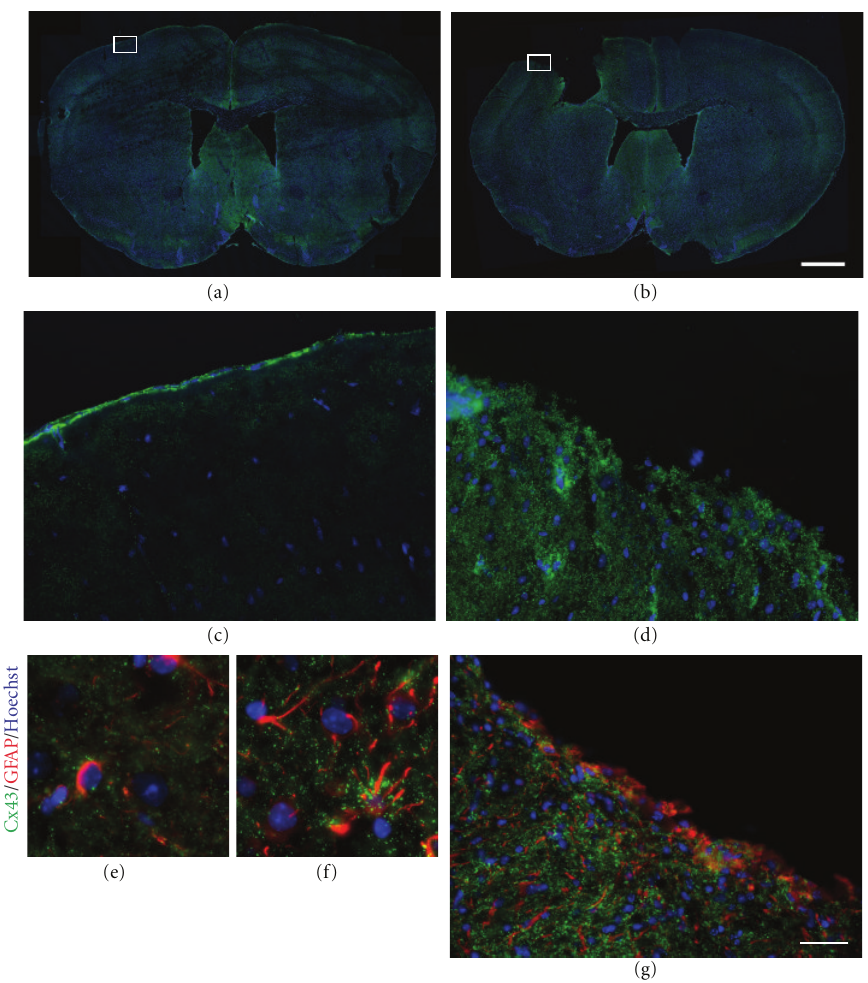
Figure 8: Cx43 expression in the control and injured motor cortices. Immunohistochemistry of Cx43 (green) in the brains of mice subjected to sham surgery (a,c,e) and motor cortex lesion (b, d, f, g). (a)-(b) The stitched confocal images show the expression of Cx43 in the control (a) and injured (b) brains. (c)-(d). Higher magnification images of the areas of motor cortex indicated by insets in (a) and (b) are shown in (c) (sham) and d (lesion). Increased Cx43 staining was observed in the cortex adjacent to the injury site compared to sham cortex. (e)–(g). Double-labeling with GFAP (red) indicated that Cx43 (green) was expressed mainly in astrocytes (red), and more abundant in the injured cortex (f, g), compared to sham cortex (e). Nuclei were stained with Hoechst (blue). All the sections were coronal. Scale bar: 1000 μ m (a)-(b), 100 μ m (c, d, g); 10 μ m (e,